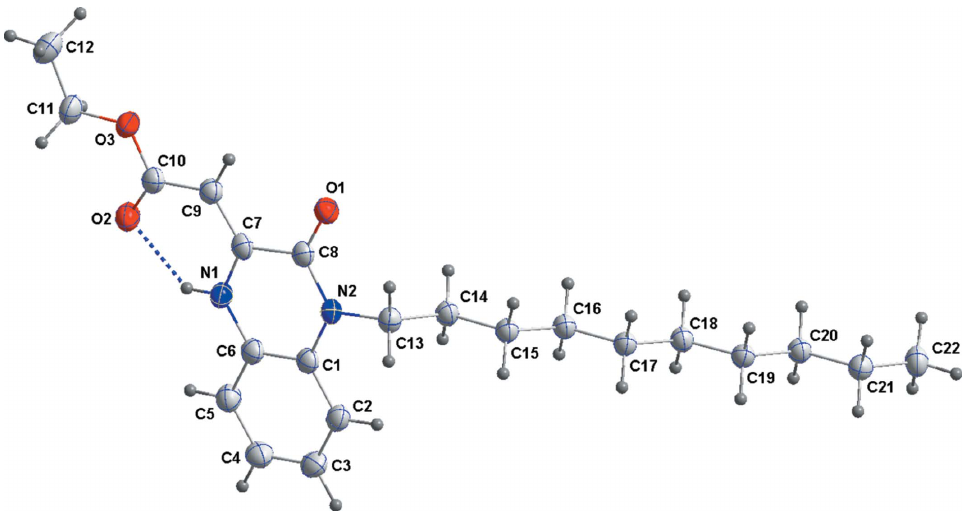
Figure 1 The title molecule, showing the labeling scheme and 50% probability displacement ellipsoids. The intramolecular N—H (cid:2)(cid:2)(cid:2) O hydrogen bond is shown as a dashed line.